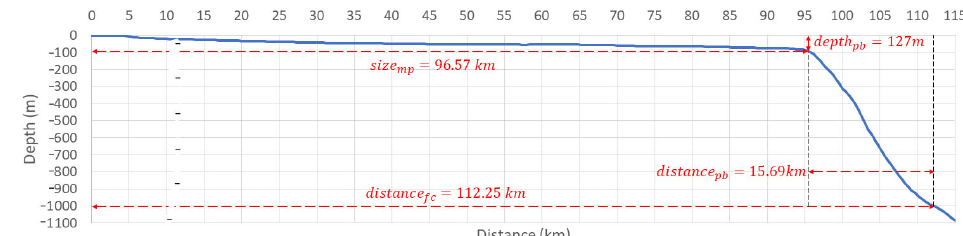
Figure 3. Bathymetric variables used in a profile and employed to propose suitable locations for the OTEC